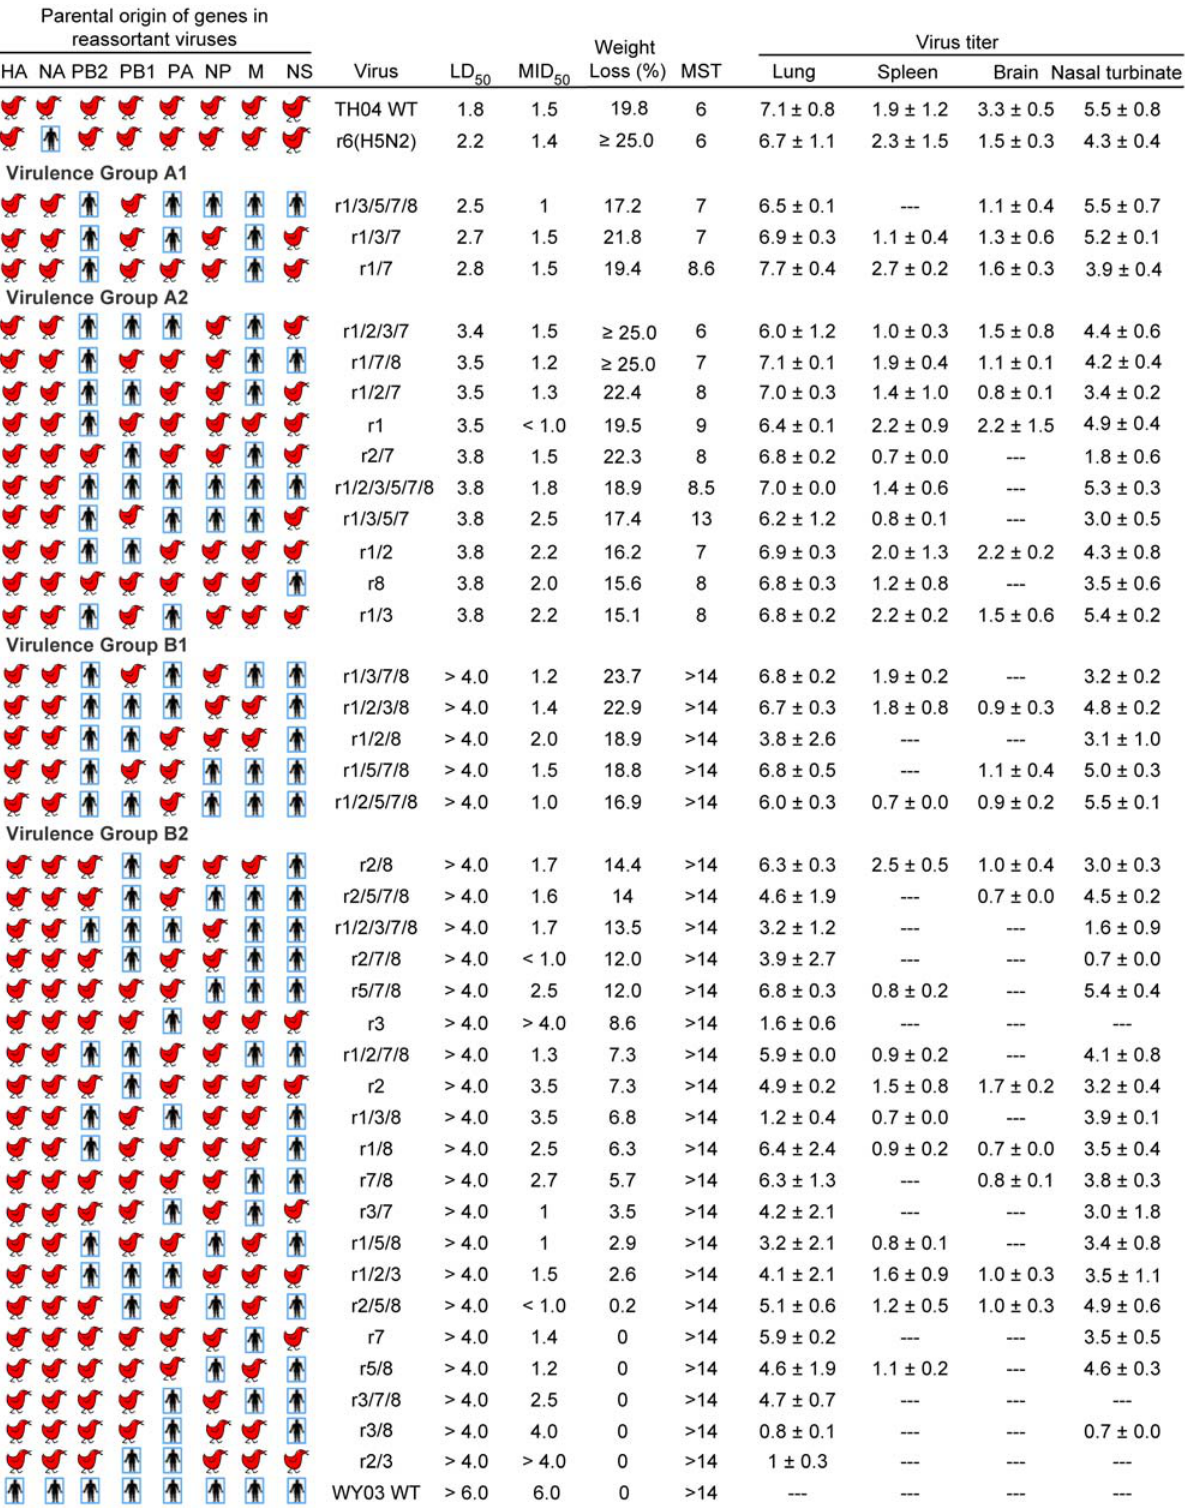
Figure 3. Replication of avian-human reassortant viruses in mice. Symbols and virus nomenclature are as in Figure 1. The mouse infectious dose (MID 50 ) and lethal dose (LD 50 ) are expressed as the log 10 pfu required to give one MID 50 or one LD 50. Maximum mean weight loss was determined from five mice per group (percent weight loss relative to dpi 0) following intranasal infection with 10 4 pfu. MST denotes the mean survival time in days following infection with 10 4 pfu. Virus titer in lung, spleen, brain or nasal turbinate are geometric means of the log 10 pfu at 4 dpi of three mice infected with 10 4 pfu. LD 50 values of rH5N1 in group A1 were significantly different from A2 and those from A1 and A2 were significantly different from TH04 WT ( P , 0.001) by analysis of variance. The — indicate that tissue titers were below limit of detection of the assay (0.7 log 10 pfu/ml). Viruses are listed in ascending LD 50 values. Viruses with identical LD 50 are listed by descending weight loss.